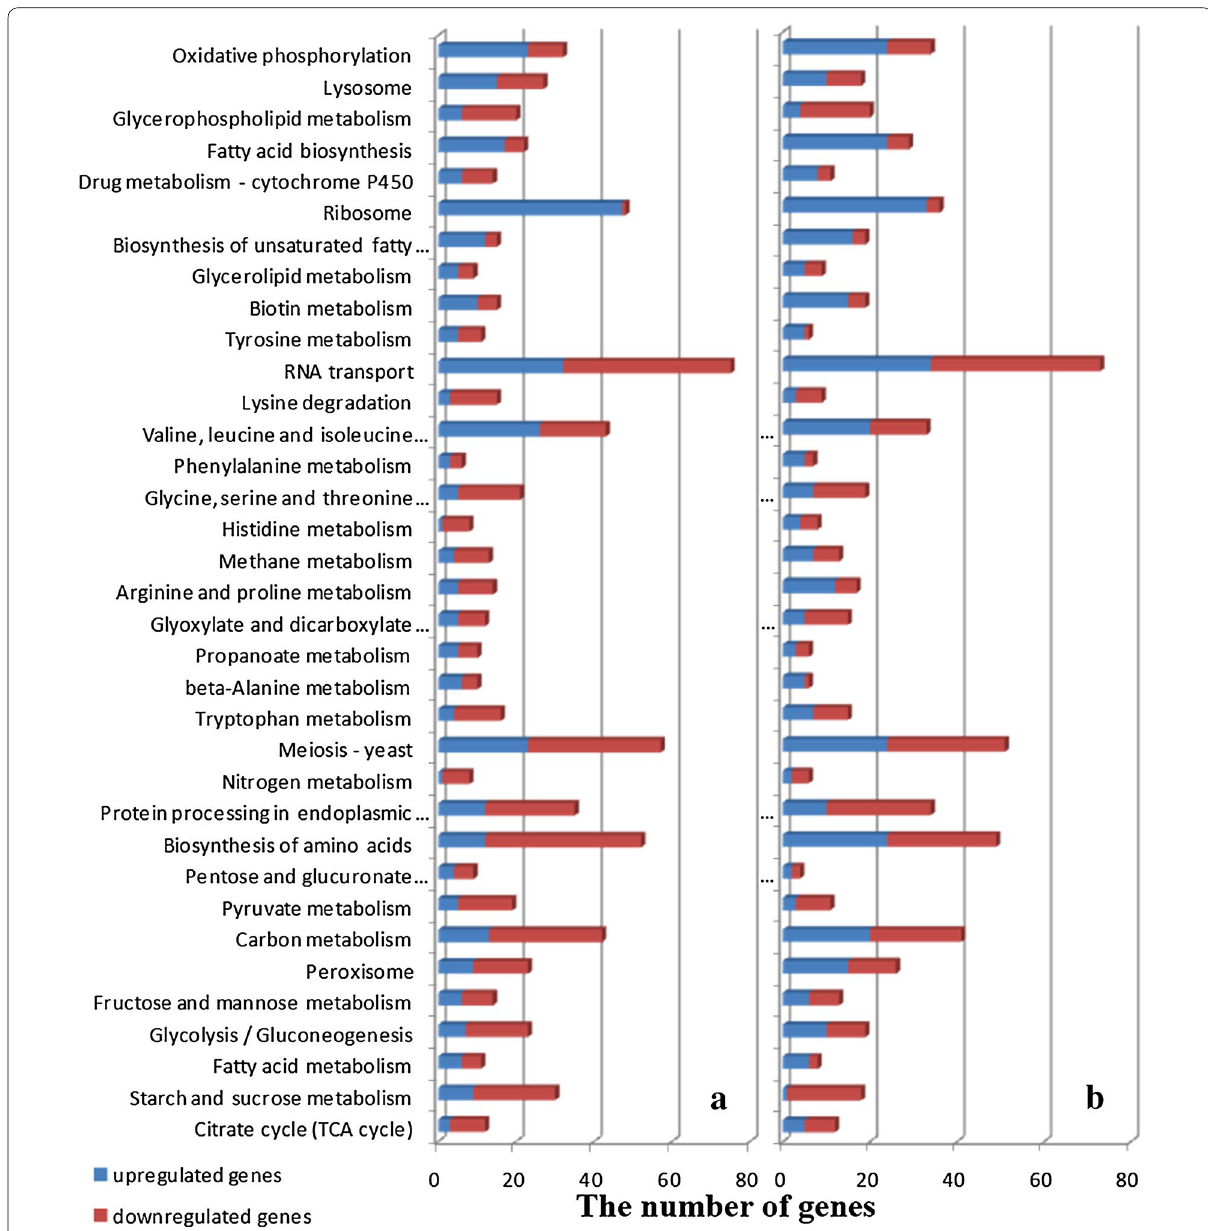
Fig. 4 Comparative transcriptomic data at 40 h clustered by KEGG categories. a Comparative transcriptomic data of strain YX‑1217 versus ATCC 1015 ( S 1/ S 3) at the peak stage of CA production (40 h culture of CA fermentation) clustered by KEGG categories. b Comparative transcriptomic data of strain YX‑1217 versus YX‑1217G ( S 1/ S 2) at the peak stage of CA production (40 h culture of CA fermentation) clustered by KEGG